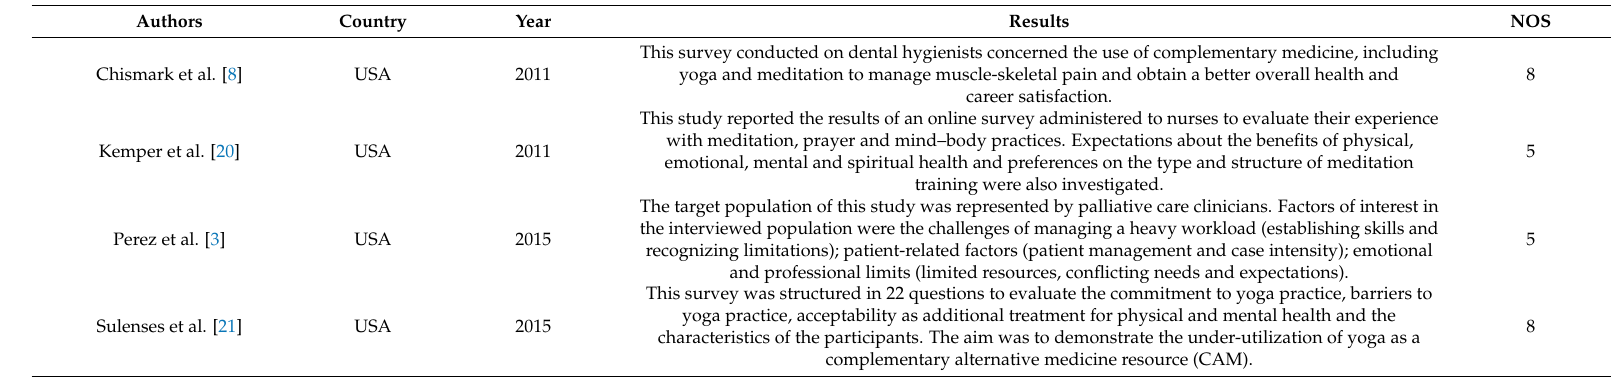
Table 2. Observational studies included in the systematic